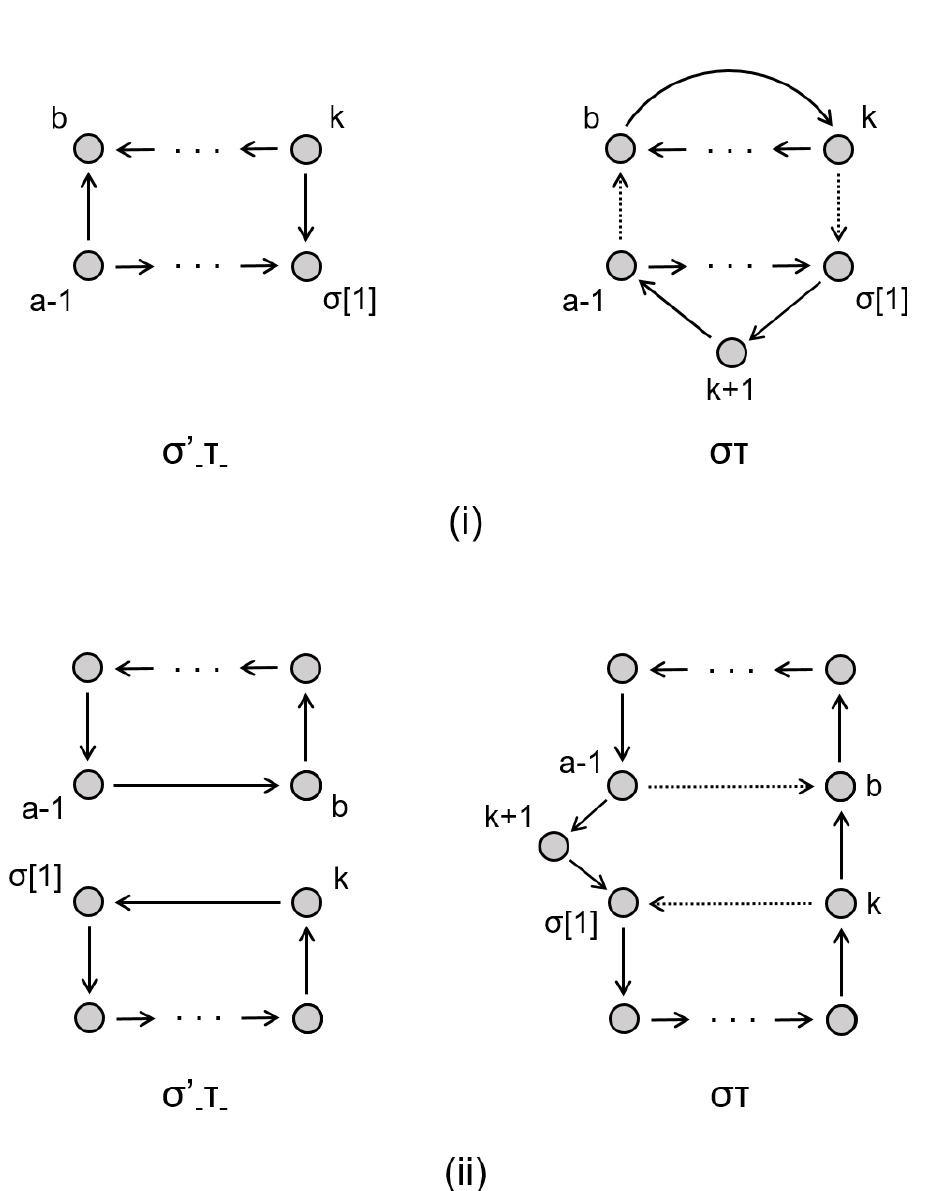
Figure 4 . Comparison between (cid:27) 0 (cid:28) (cid:0) and (cid:27)(cid:28) , when k + 1 is in a cycle of length > 1 in (cid:27) . Dashed (cid:0) arrows represent the mappings that are in (cid:27) 0 (cid:28) (cid:0) but no longer there in (cid:27)(cid:28) , and identical cycles are (cid:0) not shown. There are two possible cases: (i) The relevant elements a (cid:0) 1 ; b; (cid:27) [1] ; k belong to the same cycle in (cid:27) 0 (cid:28) (cid:0) . In (cid:27)(cid:28) , this cycle is broken into two, so (cid:27)(cid:28) has one more cycle than (cid:27) 0 (cid:28) (cid:0) ; (ii) (cid:0) (cid:0) f a (cid:0) 1 ; b g and f k; (cid:27) [1] g belong to two cycles in (cid:27) 0 (cid:28) (cid:0) . In (cid:27)(cid:28) , these two cycles are combined as one (cid:0) with element k + 1 inserted, so (cid:27)(cid:28) has one less cycle than (cid:27) 0 (cid:28) (cid:0) . (cid:0)